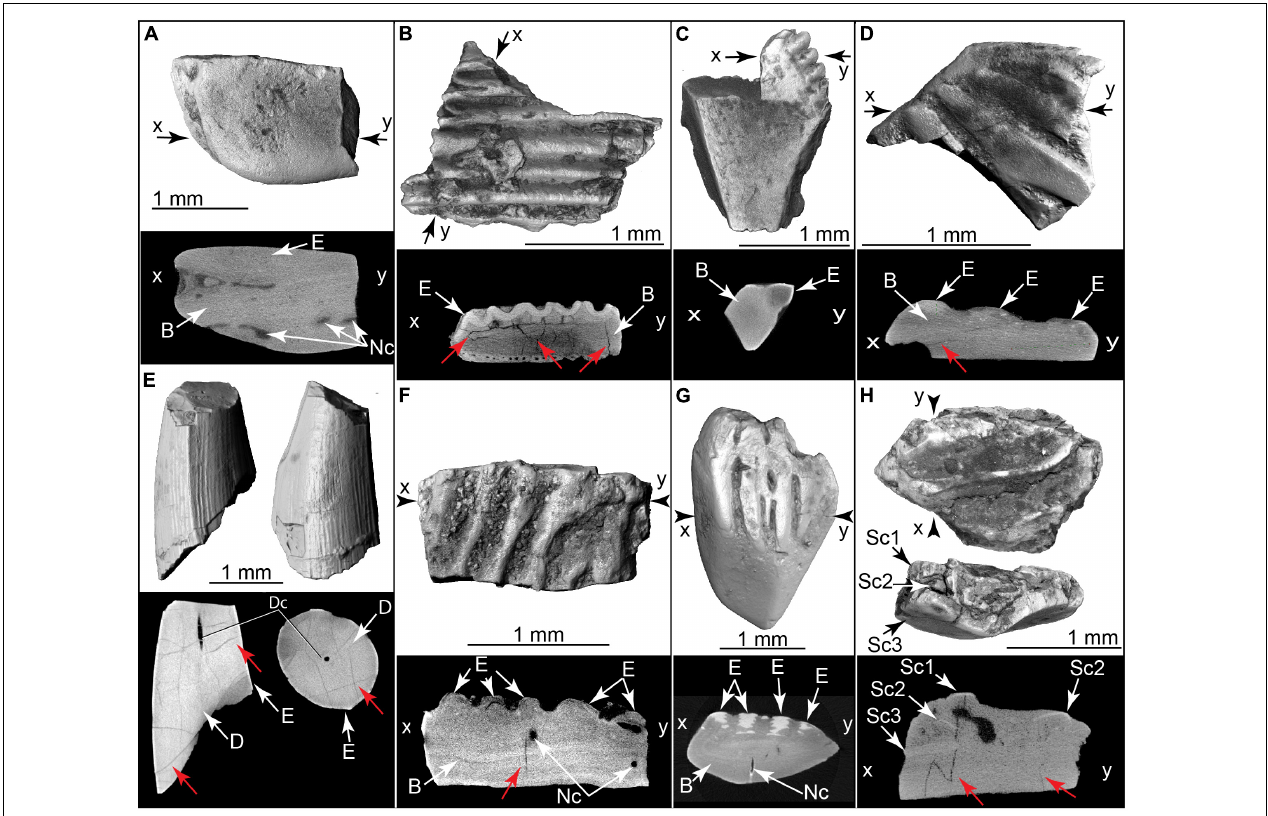
FIGURE 12 | Burnt fish teeth, fish bones, and fish scales. Volumetric 3D reconstructions from µ CT (above) and histological cross section (below). Red arrows indicate internal heat fractures. (A) Gar scale and µ CT cross section (TMM 47004-3.5.22c). (B) Cranial bone with enameloid covering, and µ CT cross section (TMM 47004-3.5.17a). (C) Fin spine (Ictaluridae?) with enamel covering and µ CT cross section (TMM 47004-3.11.10a). (D) Teleost scale and µ CT cross section (TMM 47004-3.12.5a). (E) Broken tooth in two views, plus µ CT slices (below) in sagittal (left) and horizontal (right) planes (TMM 47004-3.12.5e). (F) Broken teleost scale and µ CT cross section (TMM 47004-3.11.10g). (G) Teleost scale and µ CT cross section (TMM 47004-3.11.10f). (H) Imbricating burnt teleost scales and µ CT cross section (TMM 47004-3.11.10c). B, bone; D, dentin; Dc, dental canal; E, enamel or enameloid; Nc, nerve canal; Sc1, scale 1; Sc2, scale 2; Sc3, scale